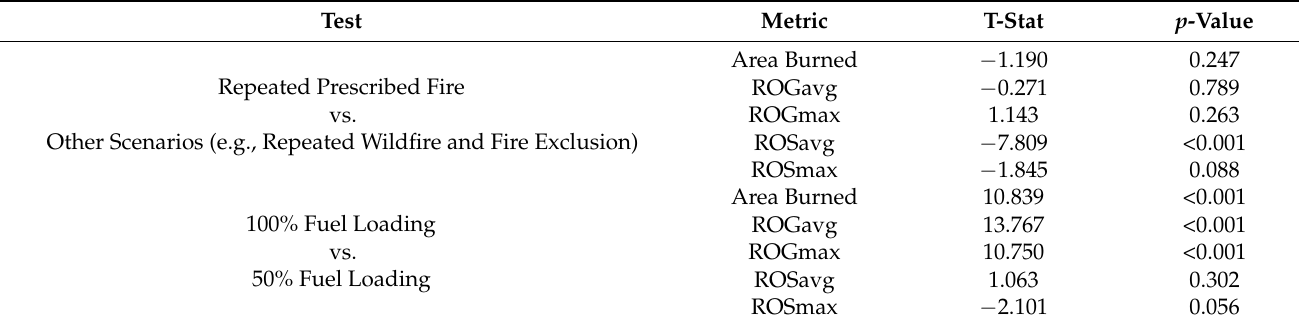
Figure 9. Influence of frequent prescribed burning structure and fuel loading on outcomes of Spring Hill Fire simulation scenarios. Boxes refer to 1st–3rd quartile, thick vertical lines within boxes refer to median, and whiskers indicate minimum and maximum values of data distributions. Table 3. T-test results of fuel management scenarios.